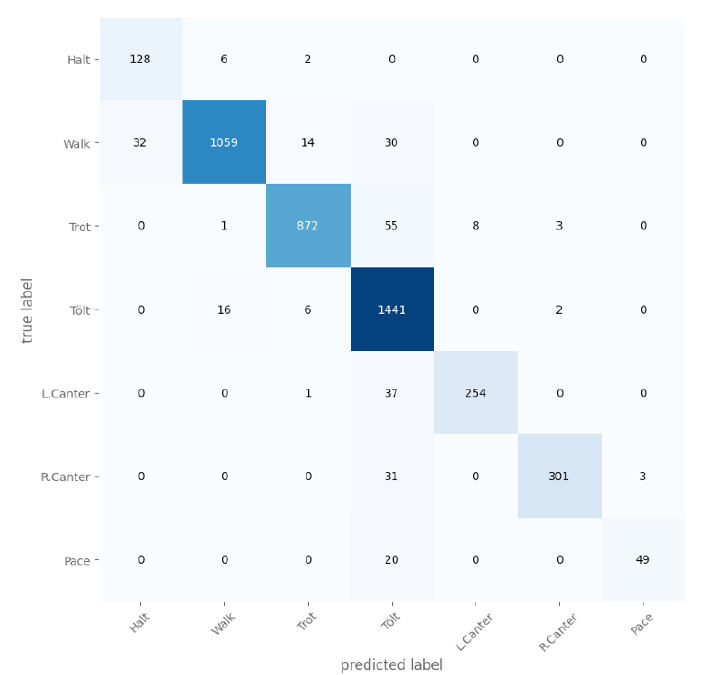
Figure 11. A confusion matrix for the case where both the TS and Judge exclusion period was 0